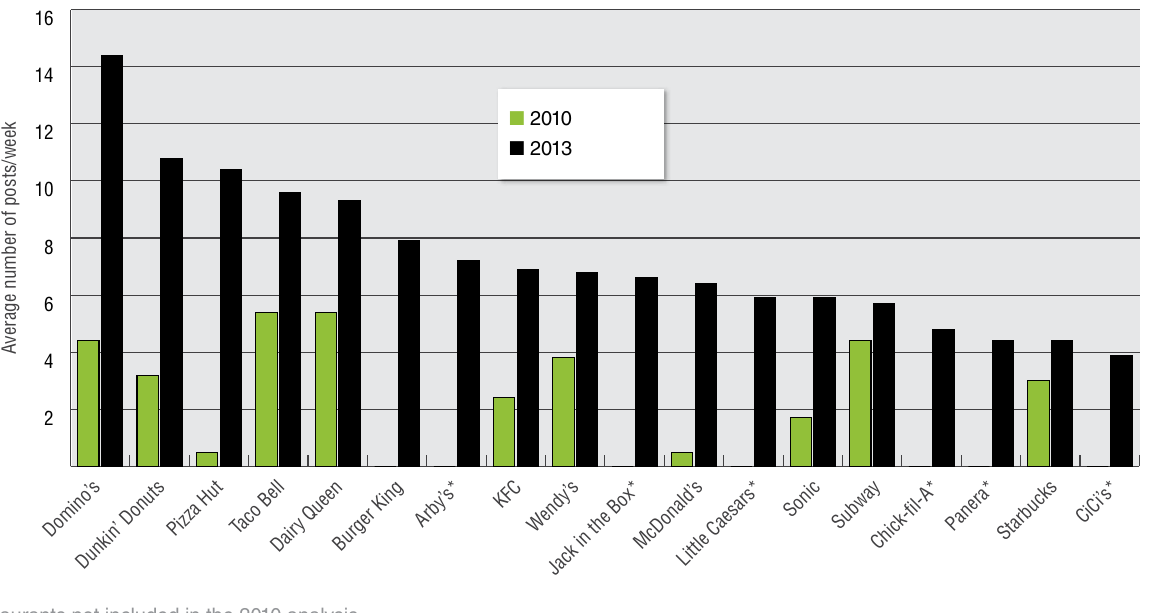
*Restaurants not included in the 2010 analysis. Source: Analysis of Facebook posts (2010; December 2012-February